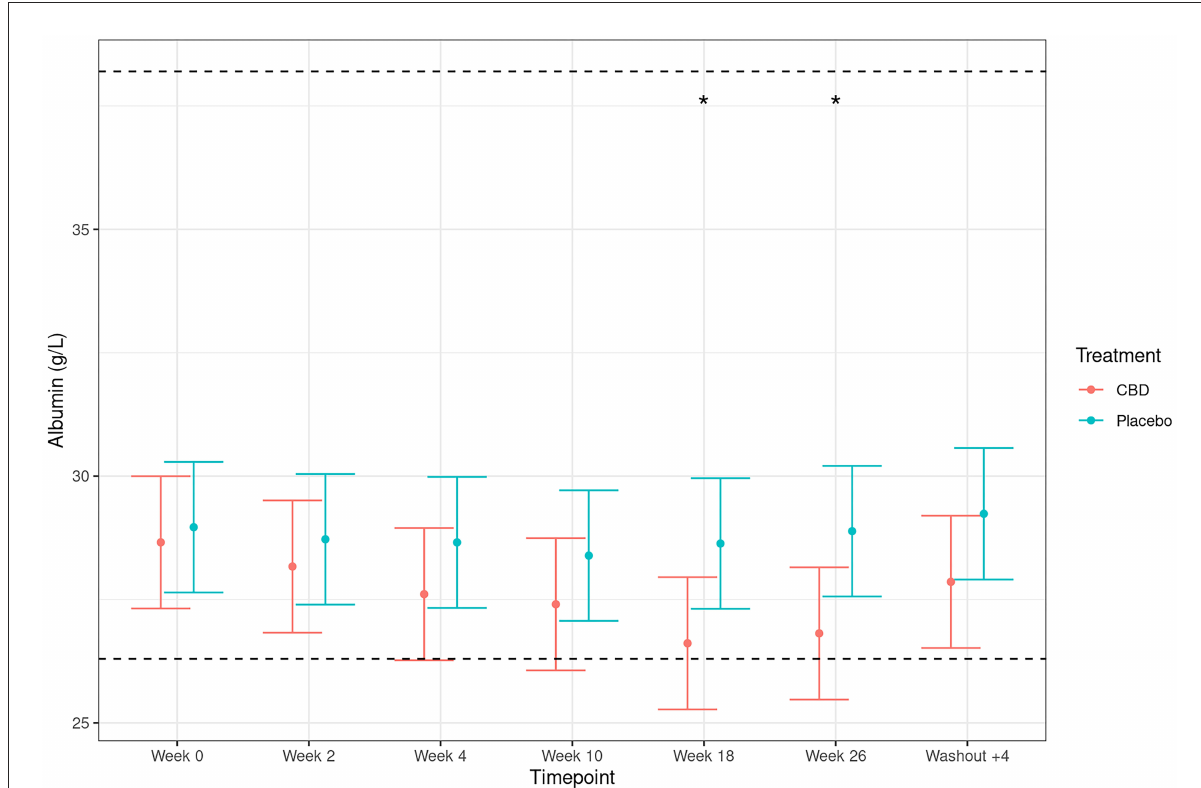
FIGURE4 Plasma concentrations of albumin (g/L; mean and 95% confidence intervals) in dogs dosed with CBD (red) and placebo (blue). Week 0 depicts the baseline measure before daily oral dosing of CBD/placebo. Dotted line depicts upper and lower reference ranges as specified by IDEXX Laboratories. *Depicts significant differences between the experimental groups ( p <